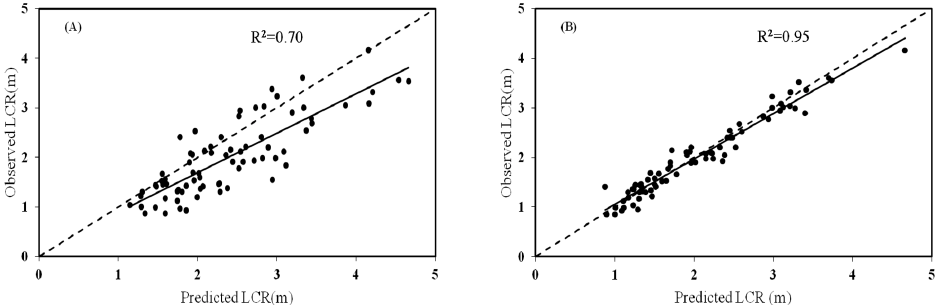
Figure 3. Observed largest crown radius ( LCR ) plotted against the predicted crown radius by the quantile regression ( A ) and quantile regression for linear mixed-effects model ( B ).